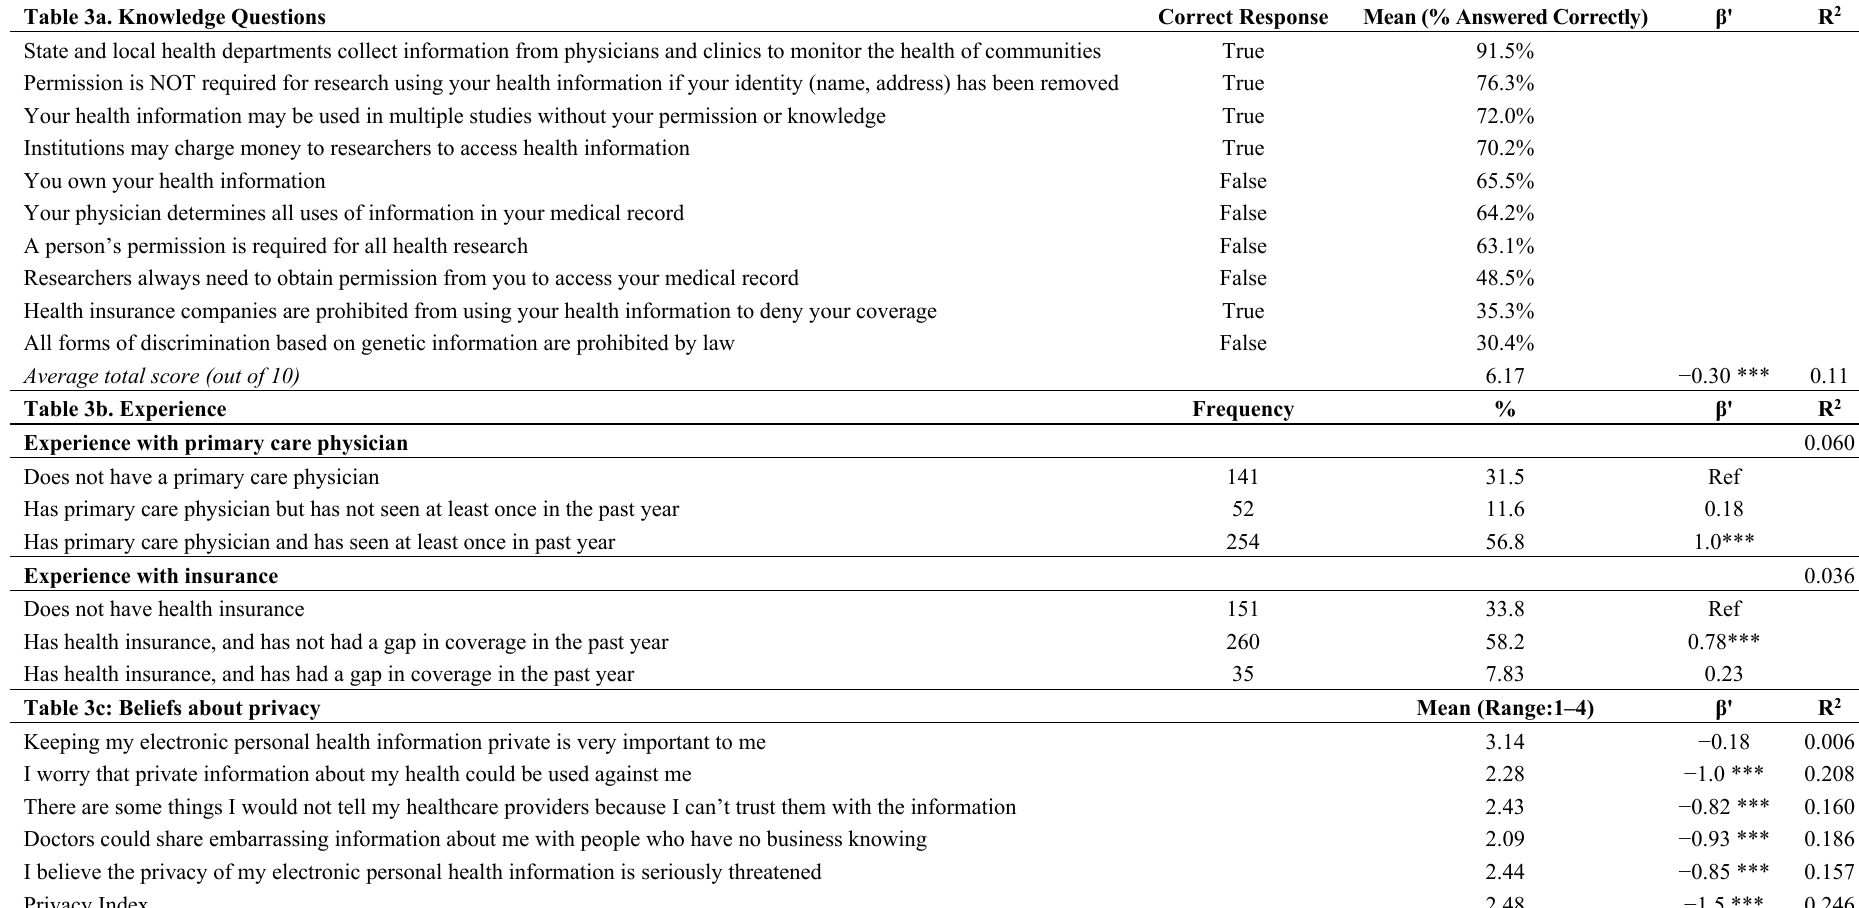
Table 3. Trustor characteristics and univariate regression relationship with System